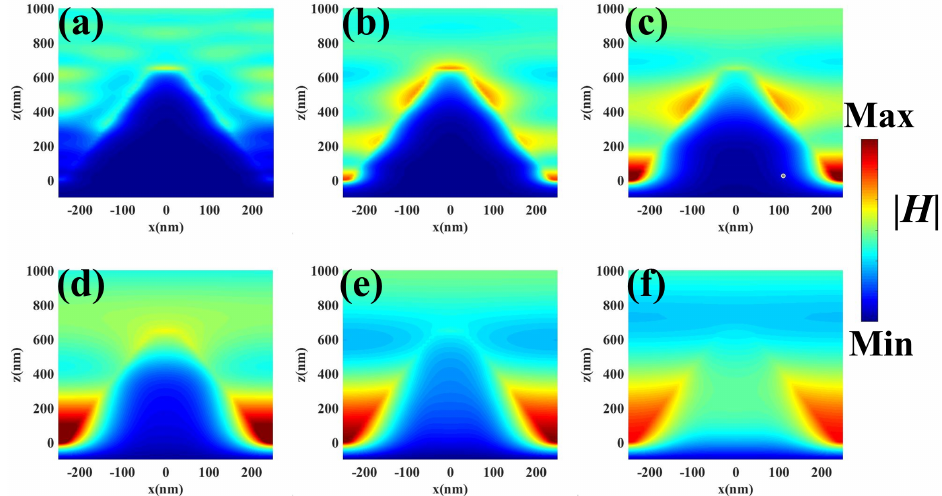
Figure 4. In the x–z plane, the magnetic field |H| distribution at wavelengths of ( a ) 254